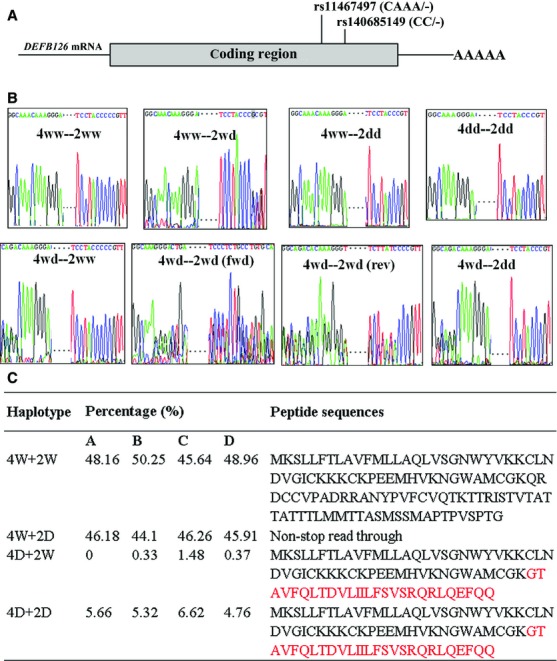
Interaction of the two indels of DEFB126 gene/a: 4ww denotes wide type of 4-nt indel (rs11467497); 4wd denotes rs11467497 ins/del genotype; 4dd denotes rs11467497 del/del genotype; 2ww denotes wide type of 2-nt indel (rs140685149); 2wd denotes rs140685149 ins/del genotype; 2dd denotes rs140685149 del/del genotype; 4W denotes rs11467497-ins allele; 4D denotes rs11467497-del allele; 2W denotes rs140685149-ins allele; 2D denotes rs1406-85149-del allele. (A) The locations of the two common indels on DEFB126 gene. (B) Sequencing plots of the two indels combinations. (C) Haplotype distribution of the two indels among the infertile males with normal sperm motility (group A), infertile males with low sperm motility (group B), fertile males (group C), and sperm donors (group D).